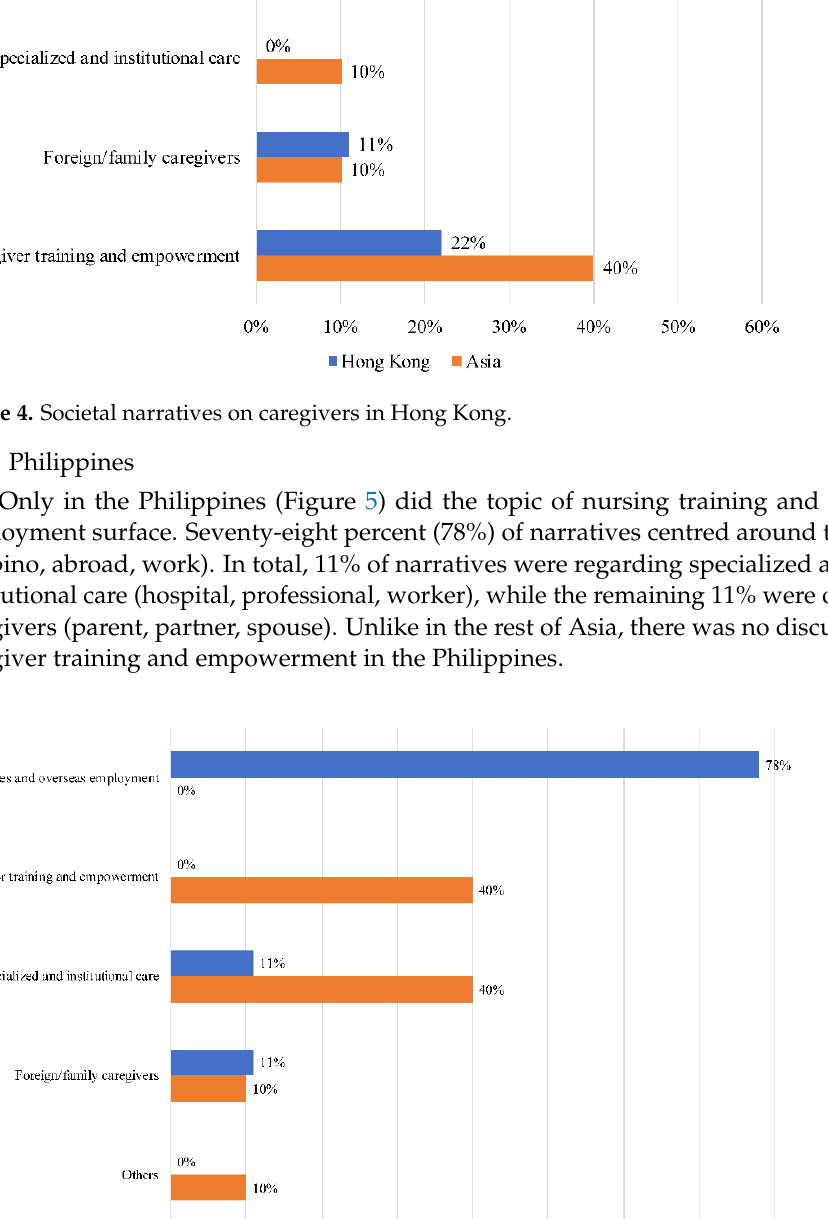
Figure 6. Societal narratives on caregivers in Malaysia. 3.2.7. Singapore Forty percent (40%) of narratives on caregivers in Singapore (Figure 7) pertained to caregiver training and empowerment (support, training, initiative)—the highest of the six countries. In total, 30% of narratives were regarding specialized and institutional care (voluntary, welfare, center). Another 20% of narratives were on caregiver burden (burden, stress, challenge), and 10% were on family caregivers (parent, compassionate, caring).